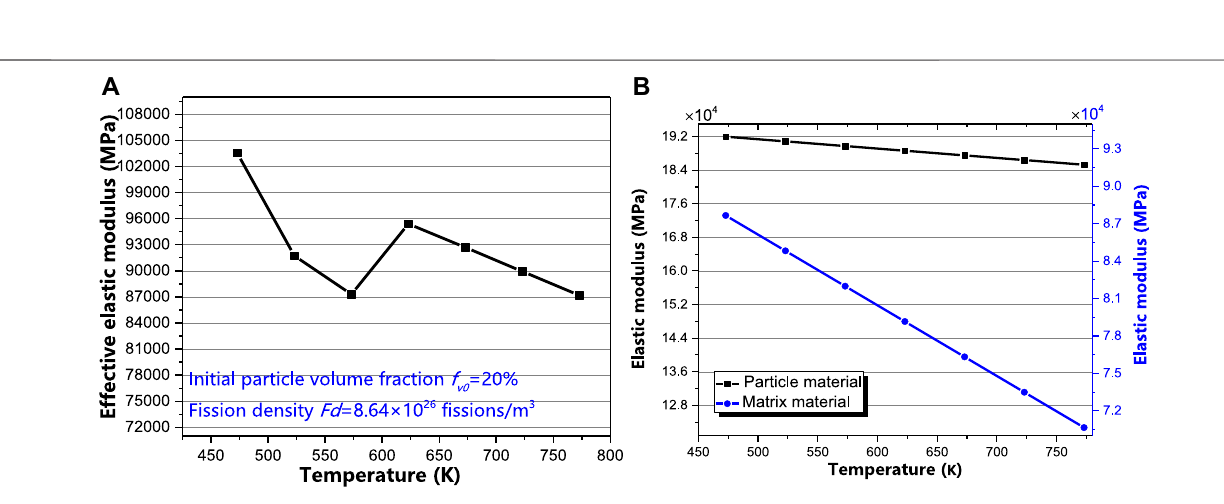
FIGURE 12 | (A) Postirradiation effective elastic modulus under different temperatures and (B) the elastic modulus of the particle material and matrix material.